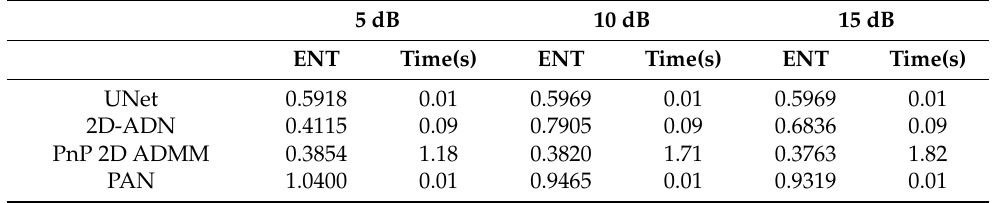
Figure 7. The missing data pattern of ( a ) 75% loss rate and ( b ) 90% loss rate.